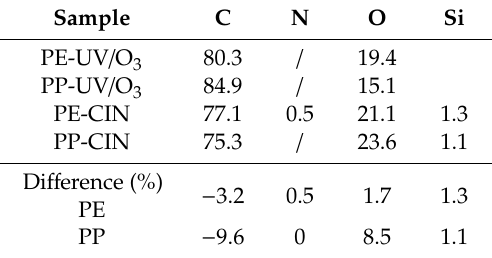
Table 8. Surface chemical composition (at. %) of the reference foils and foils treated by cinnamon coating. Sample